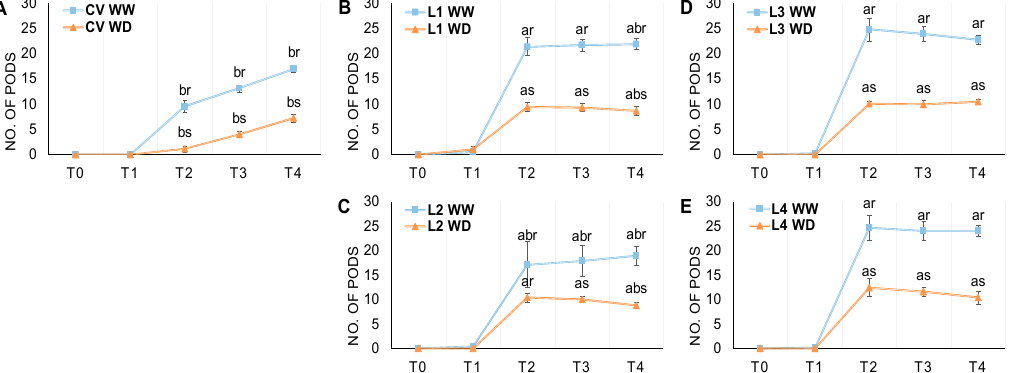
Figure 3. Pod development (No. of pods) of Portuguese cowpea plants, a commercial variety (CV) ( A ) and four landraces, L1 ( B ), L2 ( C ), L3 ( D ), and L4 ( E ) under well-watered (WW) and water deficit (WD) conditions, at the beginning of treatment (T0) and 5, 7, 9, 10 and 11 weeks after, T1, T2, T3, and T4, respectively. Values represent mean ± SE ( n = 5 to 10). Different letters mean significant differences between varieties (a, b, c) and between treatments for each variety (r, s). The letters (a) and (r) correspond to the highest values. (ANOVA, p <